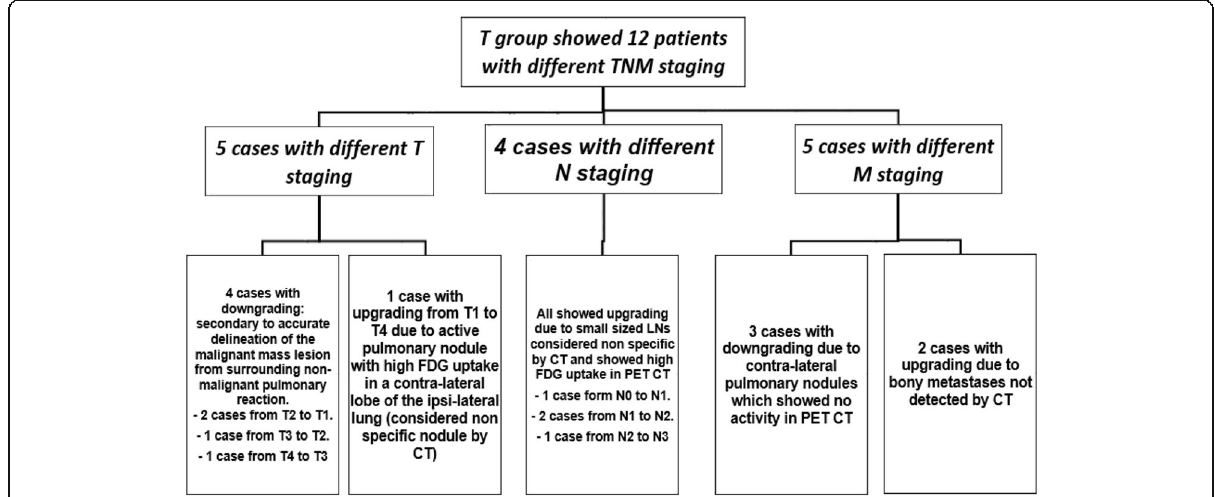
Fig. 10 A diagram illustrating the different TNM stagings between the PET/CT and CT results found between the group T population illustrating the different causes of these differences between the two modalities